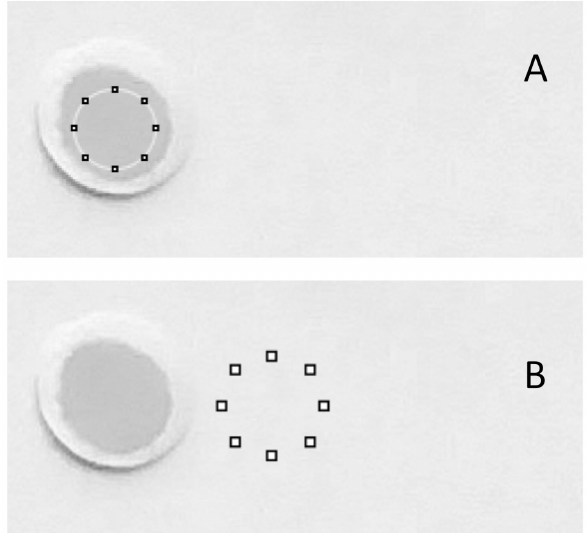
Figure 1. ( A ) Measured area of the protein-stained part of the disc. ( B ) Measured area close to the disc to correct for background. The difference in mean gray value = mean gray value ( B )–mean gray value ( A